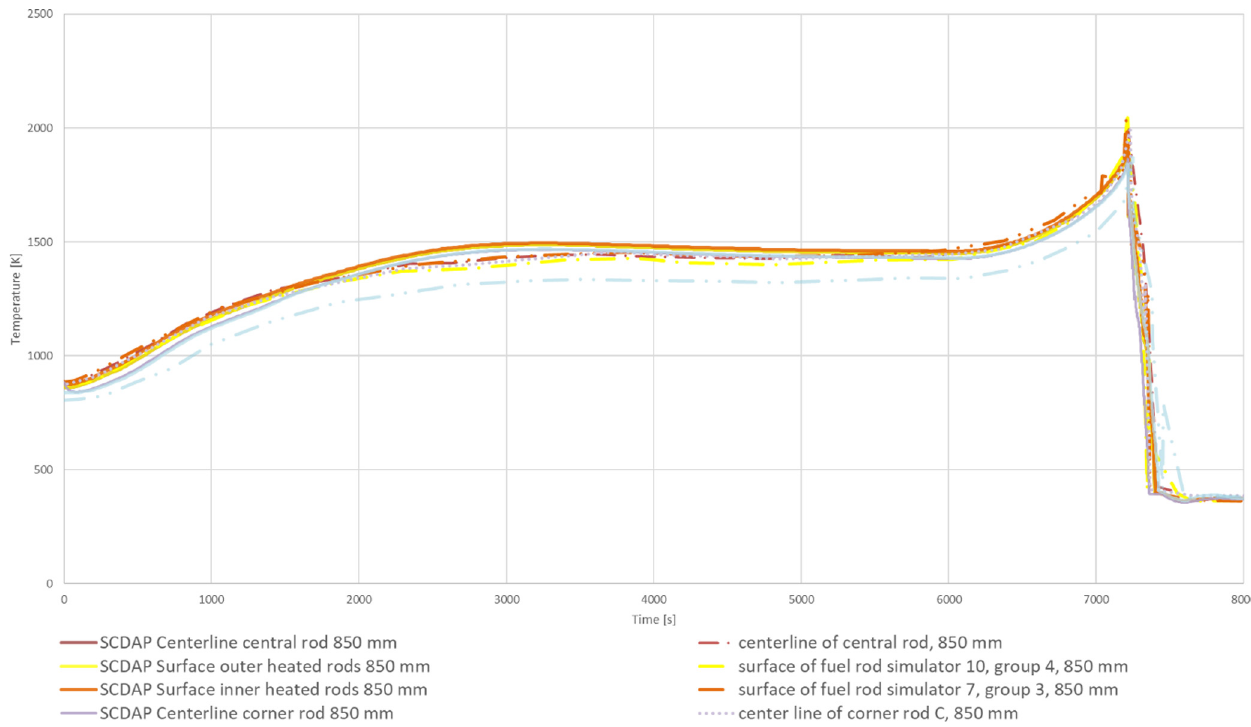
Fig. 7. Thermocouple readings at elevation 850 mm.